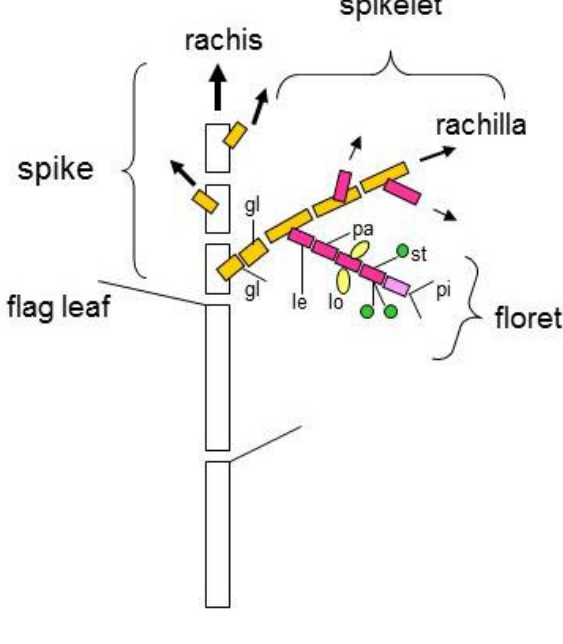
Figure 2. Schematic illustrations of the phytomeric structures of the wheat inflorescence. The spikelets are arranged as two opposite rows of lateral branches from the main axis (rachis). Each spikelet is composed of florets joined at the axis (rachilla) alternately on opposite sides, and enclosed by two glumes. Each floret is composed of a lemma, a palea, two lodicules, three stamens and a pistil. gl, glume; le, lemma; pa, palea; lo, lodicule; st, stamen; pi,